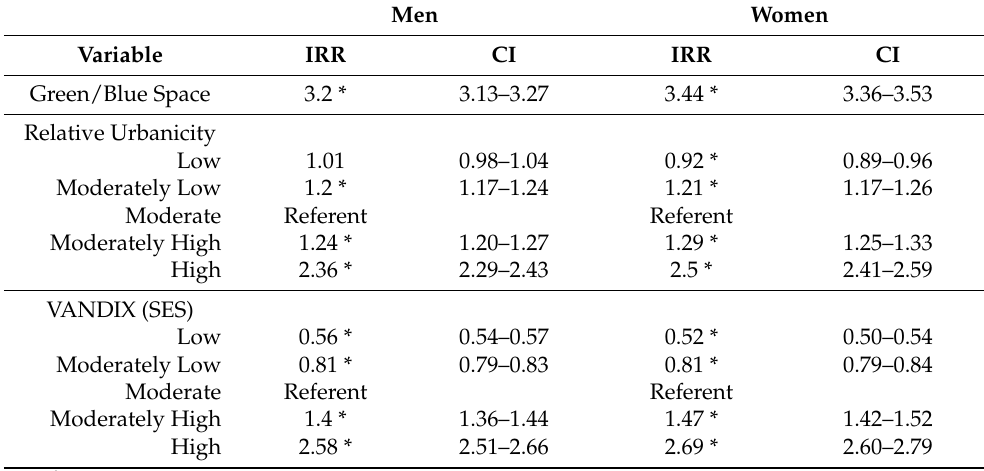
Table 3. Strava Runners by